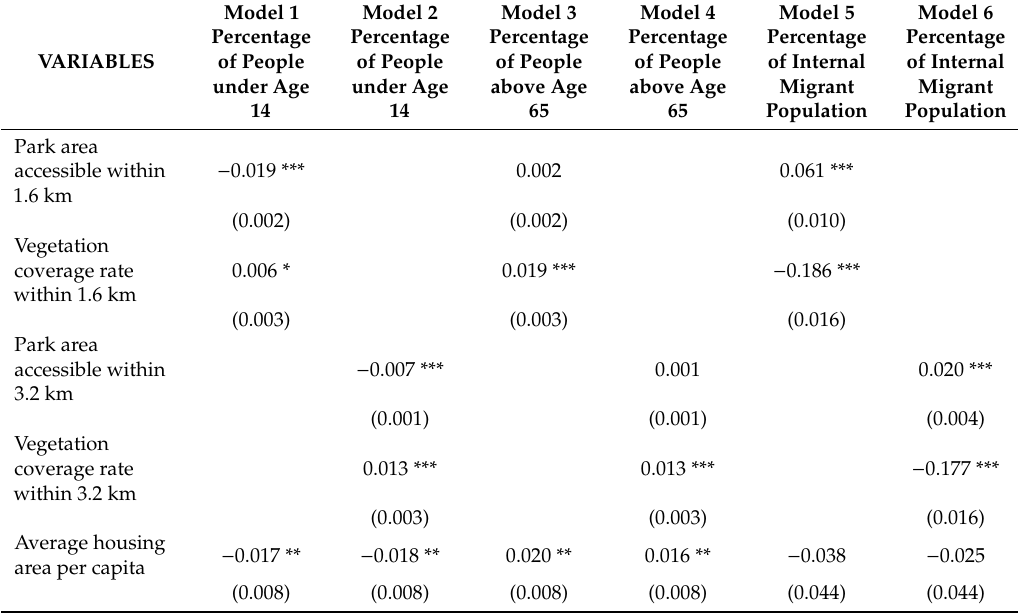
Table A2. Sensitive analysis: regression for entire country using townships within urban land